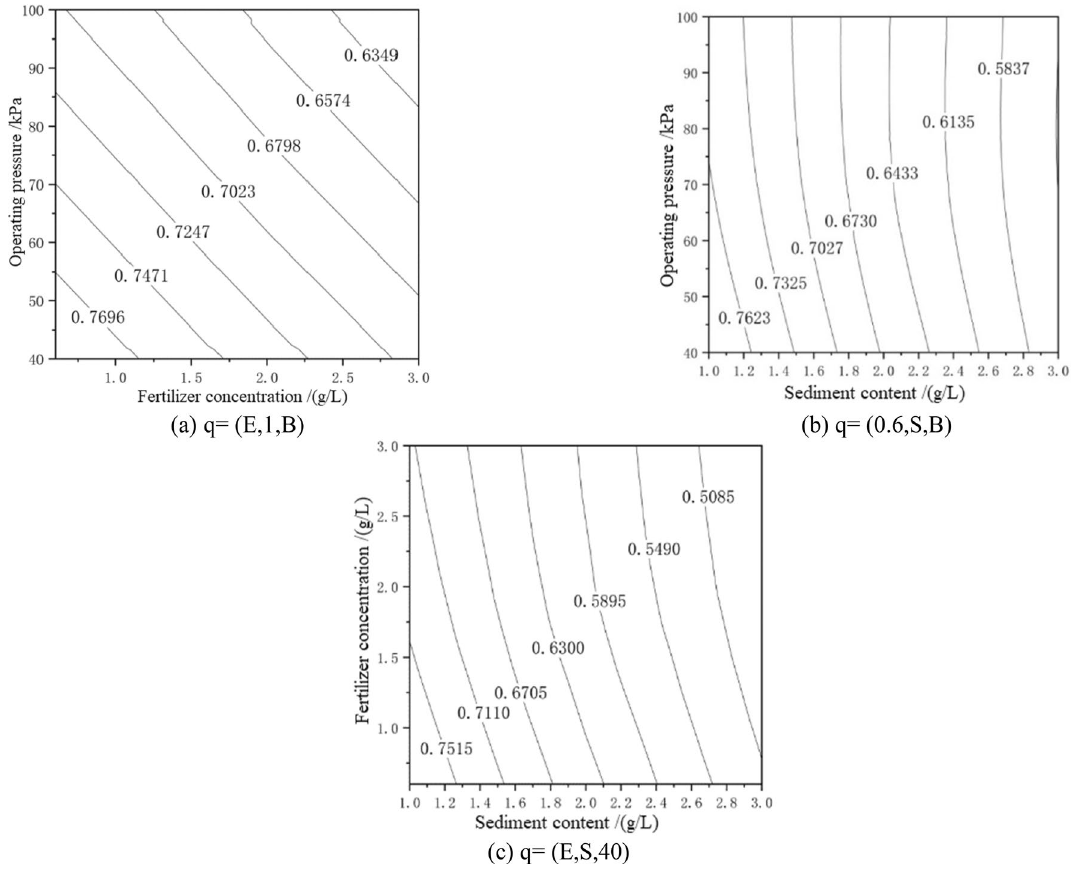
Figure 4. PPR contour map for H1 drip irrigation